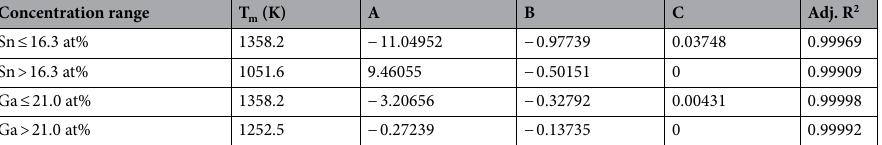
Table 2. Coefficients for the polynomial fitting functions of the liquidus lines for the binary systems Cu–Sn and Cu–Ga. For Sn and Ga concentrations > 16.3 at% and > 21.0 at%, parabolic fitting functions were used. As a measure for the fit quality, adjusted R 2 values are given for each set of